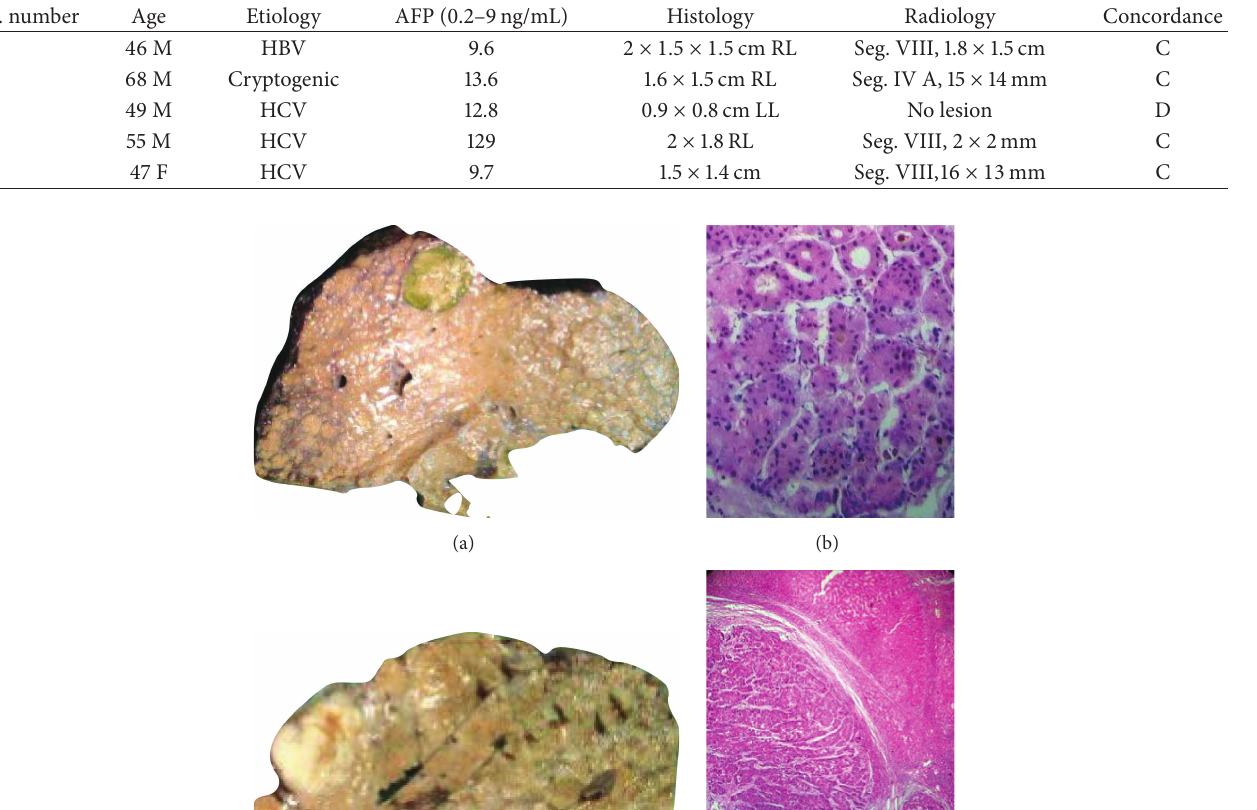
Table 2: Etiopathological association of small HCC with AFP level and triple phase CECT.